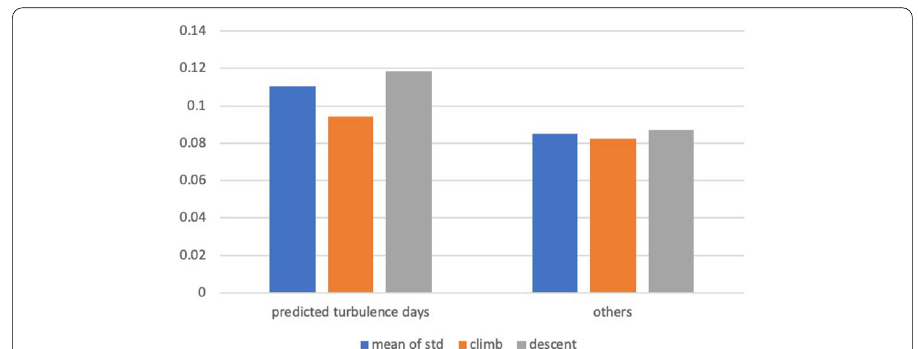
Fig. 10 Comparison of the average of the maximum SDs of vertical sway for days with and without predicted turbulence from QAR